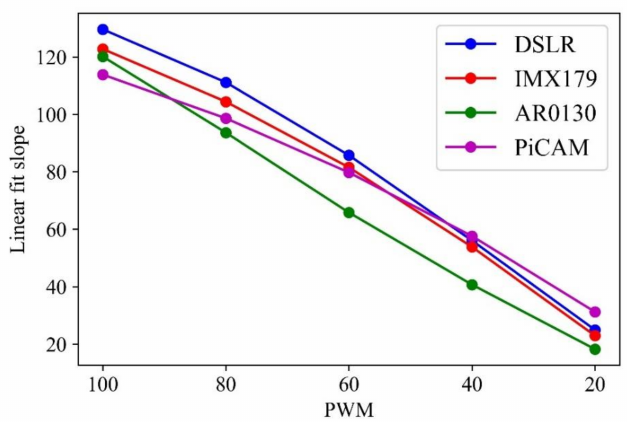
Figure 7. First-order parameter slope according to PWM for each camera.